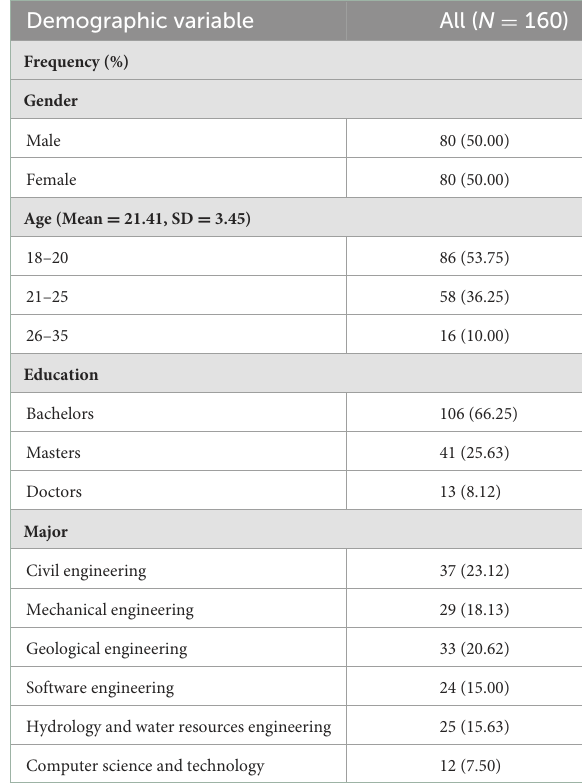
TABLE 1 Profile of